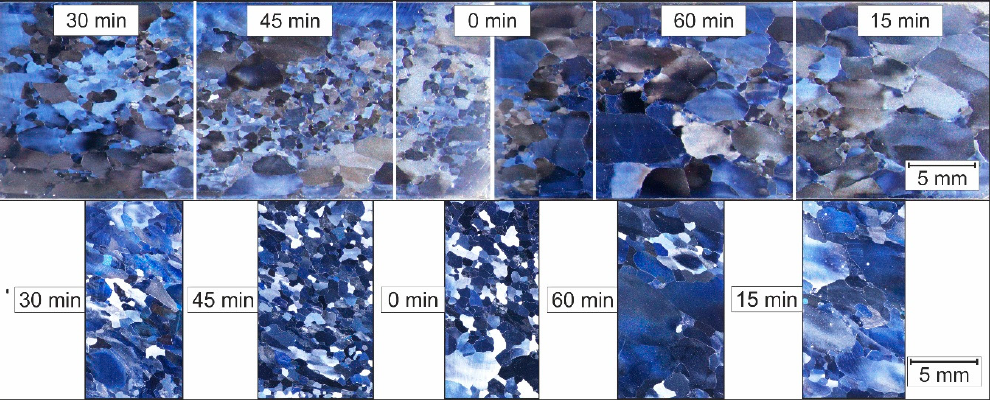
Figure 6. The forming history of the microstructure of Fe9Al. Above: microstructure and sampling point before ECAP- process (left half fine grain, right half coarse grain); below: after one ECAP pass and heat-treated at 750 °C with different recovery times.